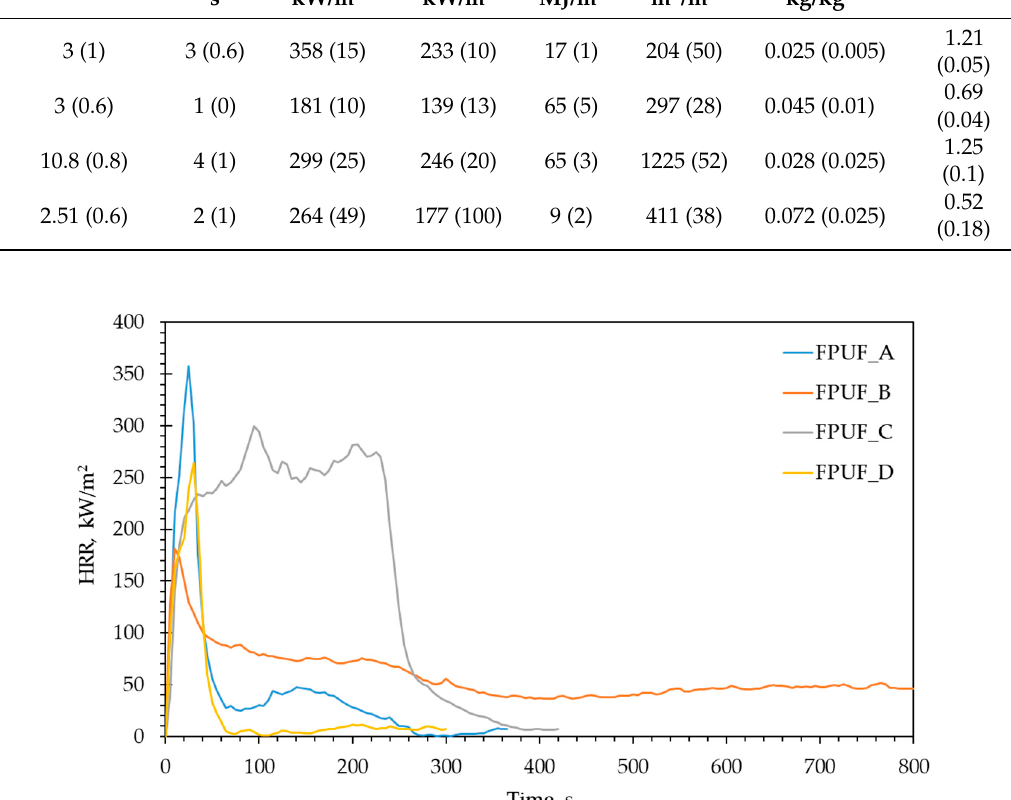
Figure 2. Representative heat release rate (HRR) curves of tested flexible polyurethane foams.